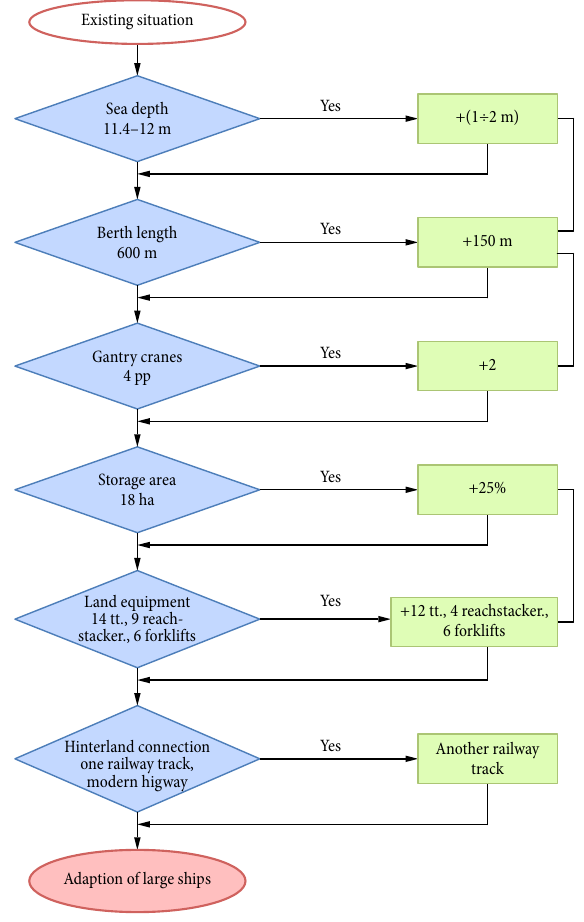
Fig. 4. Optimization results for the port of